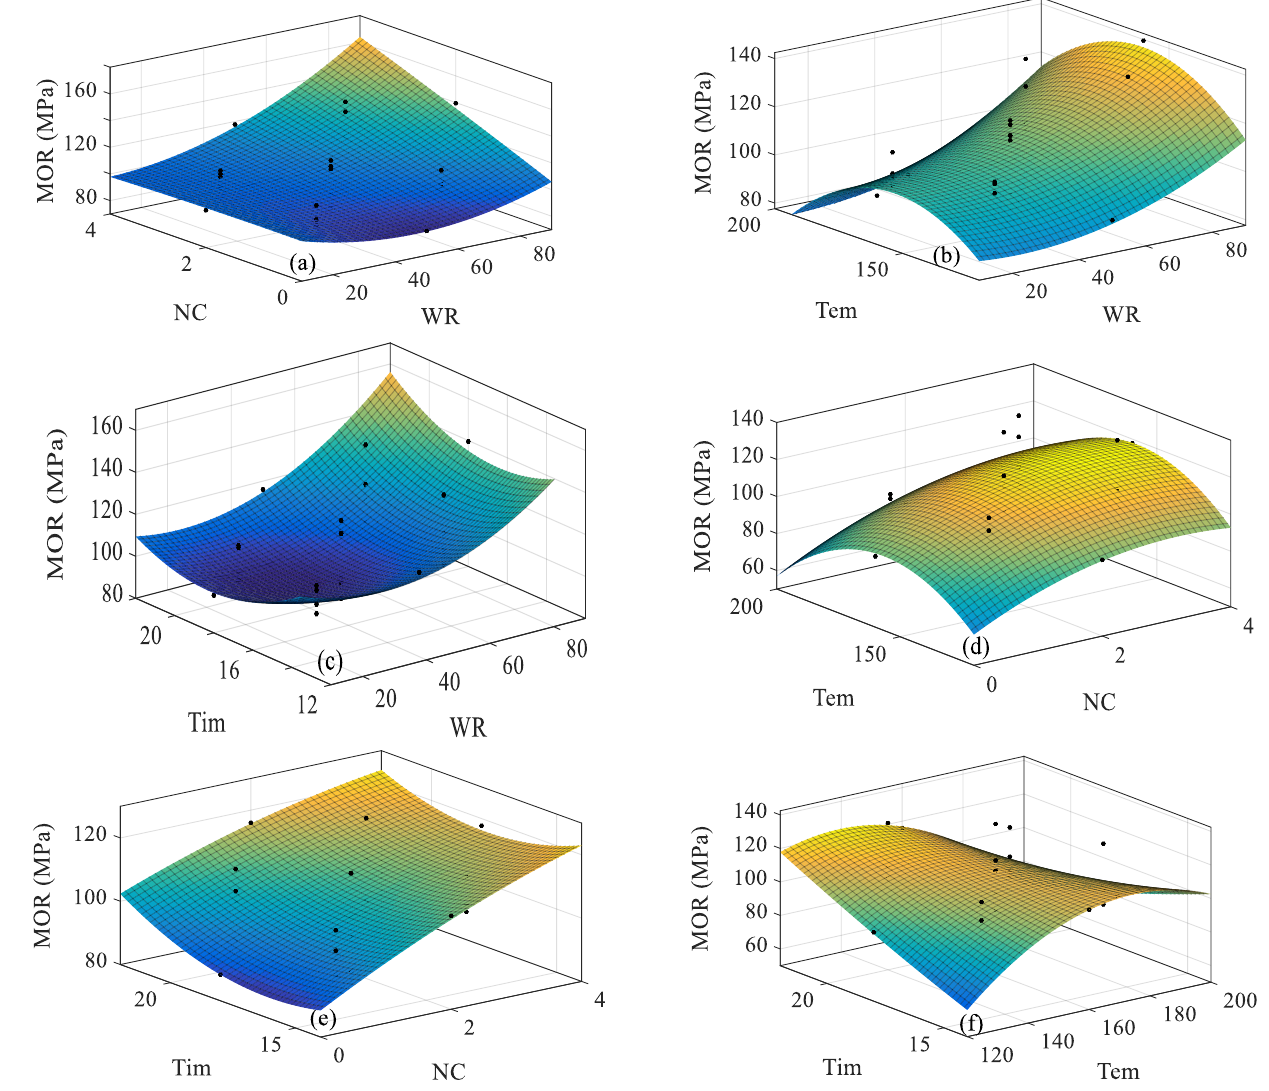
Figure 5. The interactive effects of WR × NC ( a ), WR × Tem ( b ), WR × Tim ( c ), NC × Tem ( d ), NC × Tim ( e ) and Tem × Tim ( f ) on the MOR.